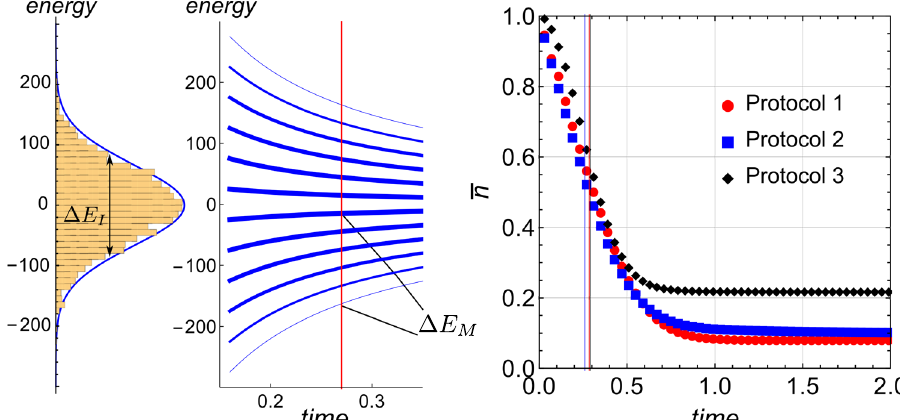
Fig. 1 Characteristic annealing time. Left: histogram of the spectrum of the Hamiltonian H I (2) with Gaussian distribution of all coef fi cients a { k } . Middle: time evolution of the spectrum of the transverse fi eld Hamiltonian H 0 (17) with quench schedule g ( t ) = g / t , where g = 4. (Thicker curves correspond to the M higher density of states). The vertical line marks the annealing time τ a (18), for which the gap between the ground state and the highest density point in the spectrum equals the bandwidth Δ E I (full width at half maximum) of the spectrum of H I . Right: time evolution of the (normalized to 1) excitations (cid:2) Table 1. The colored vertical lines mark the corresponding times at which the excitations reach the halfway into their saturation, which veri fi es almost the same effective annealing rate for the protocols with the same τ a